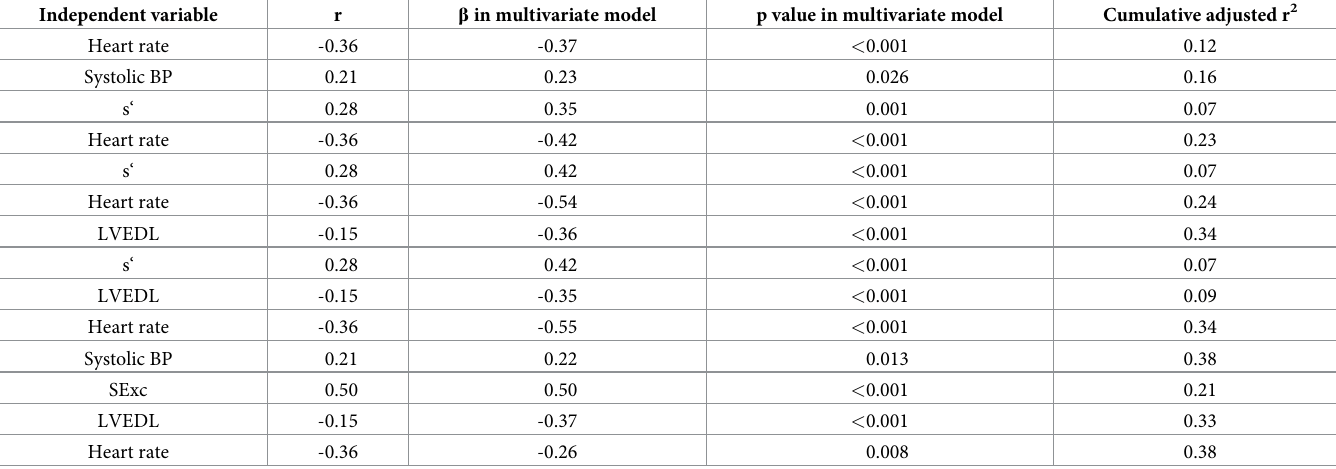
Table 4. Models of the absolute value of GLS including heart rate and blood pressure.